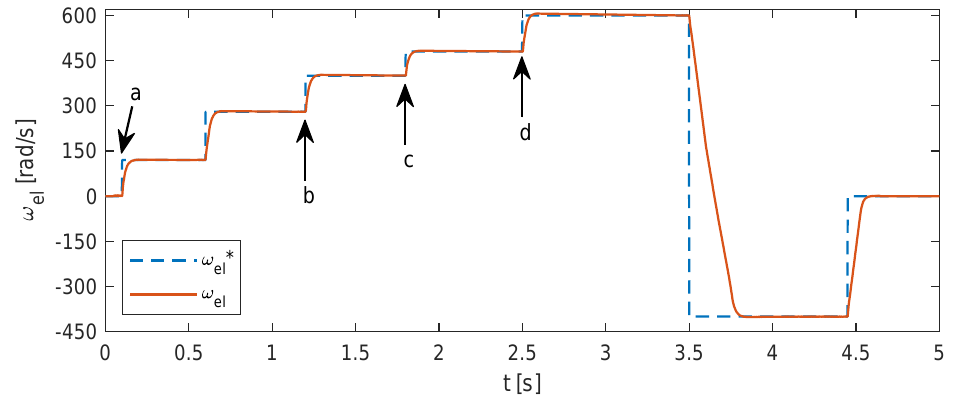
Figure 7. Speed profile of the experimental evaluation. Speed request is displayed in a dashed blue line, the actual speed in a red full line. Letters a, b, c and d indicate moments that are analyzed in detail in Figure